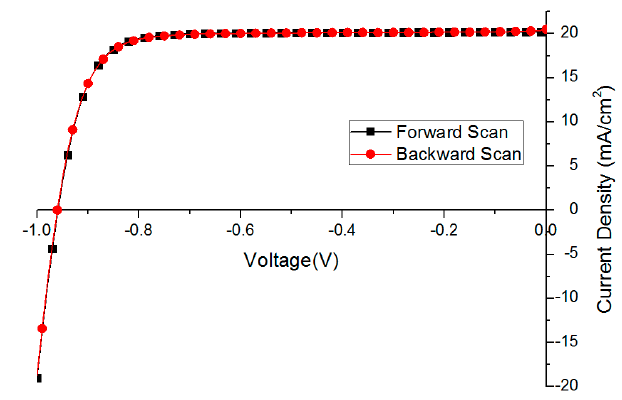
Figure 6. The best solar cell performance without hysteresis behavior (scan rate 0.1 V/s). Table 4. The best perovskite solar cell performance after full optimization. Scan direction PCE (%) FF V OC (mV) J SC (mA/cm 2 )